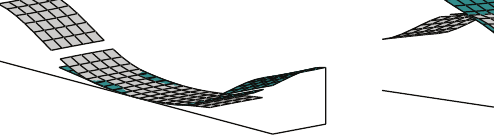
Figure 4: First three columns of matrix Φ 𝑉